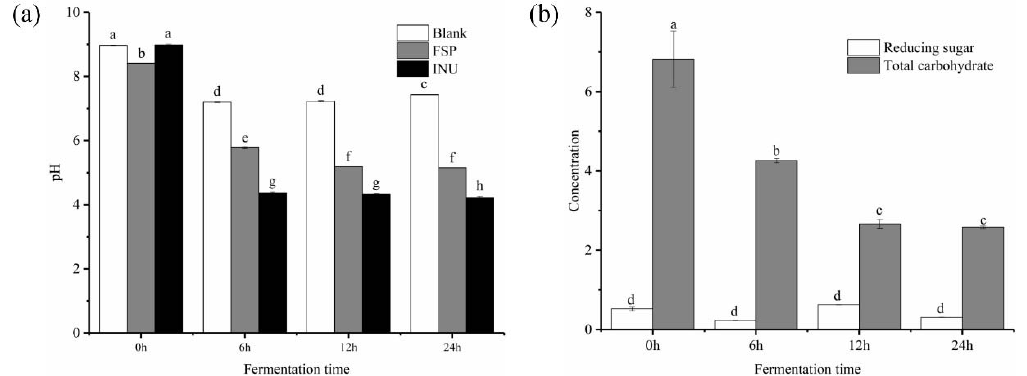
Figure 2. Shift of pH during in vitro fermentation ( a ) and change of contents of total carbohydrate reducing sugar during fermentation ( b ). a–h means significantly di ff erent ( p < 0.05) by a Tukey test in and reducing sugar during fermentation ( b ). a–h means significantly different ( p < 0.05) by a Tukey the same time between each two group. test in the same time between each two group.